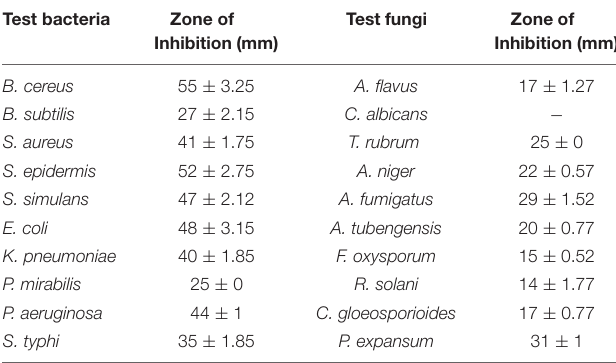
FIGURE 1 | (A) Paenibacillus elgii isolate was grown on nutrient agar plates. (B) Neighbor joining Phylogenetic tree showing the position of isolate P. elgii with other species of the genus Paenibacillus sp. and related taxa based on 16S rDNA gene sequences. Bootstrap values (expressed as percentages of 1000 replications) are